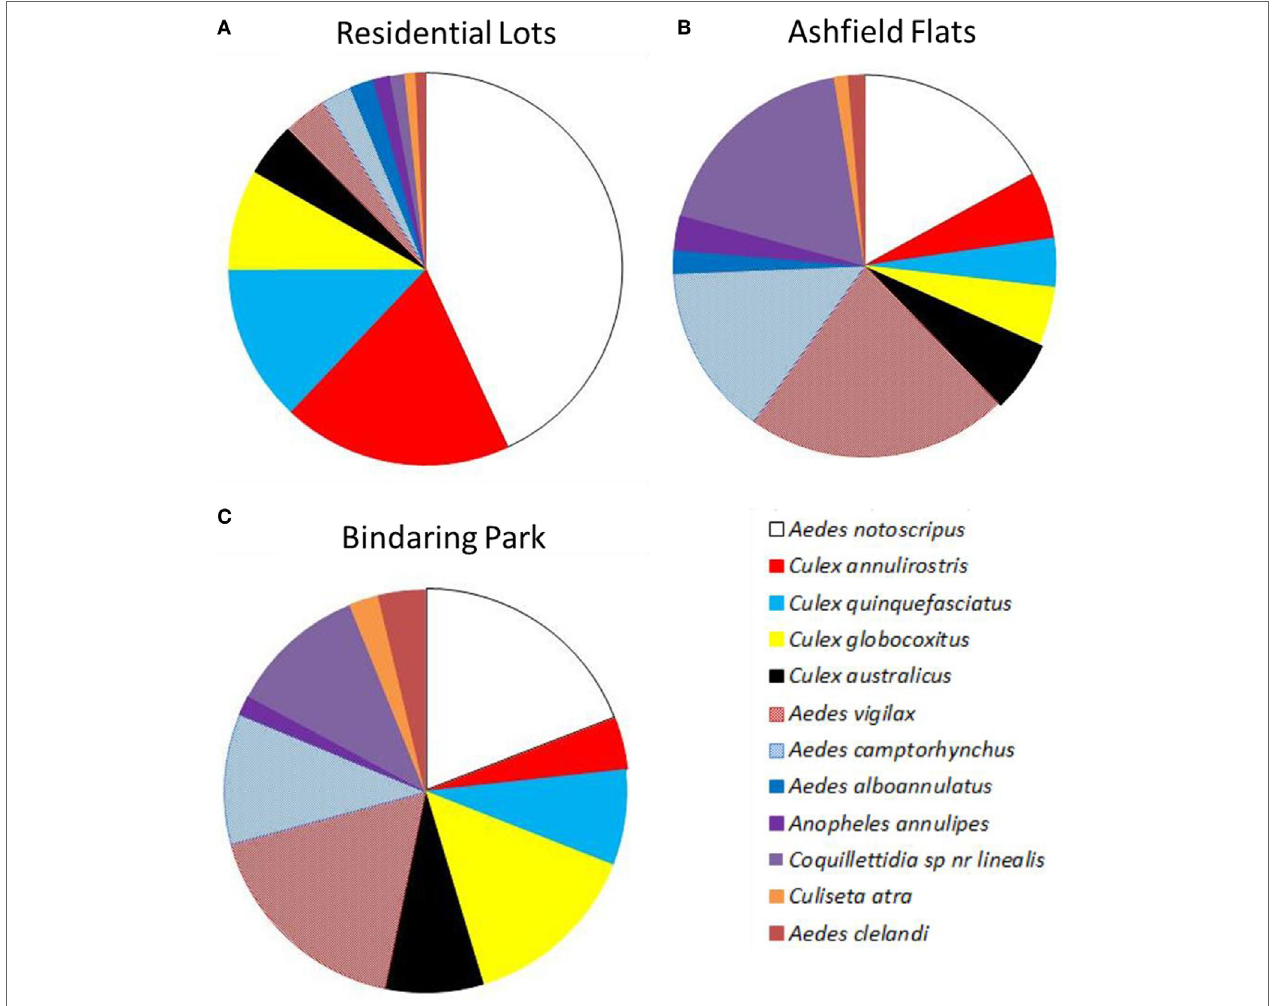
FigUre 7 | Average composition of adult mosquito species per trap night collected in encephalitis virus surveillance carbon dioxide traps across the study area, including (a) residential sites, (B) Ashfield Flats, and (c) Bindaring